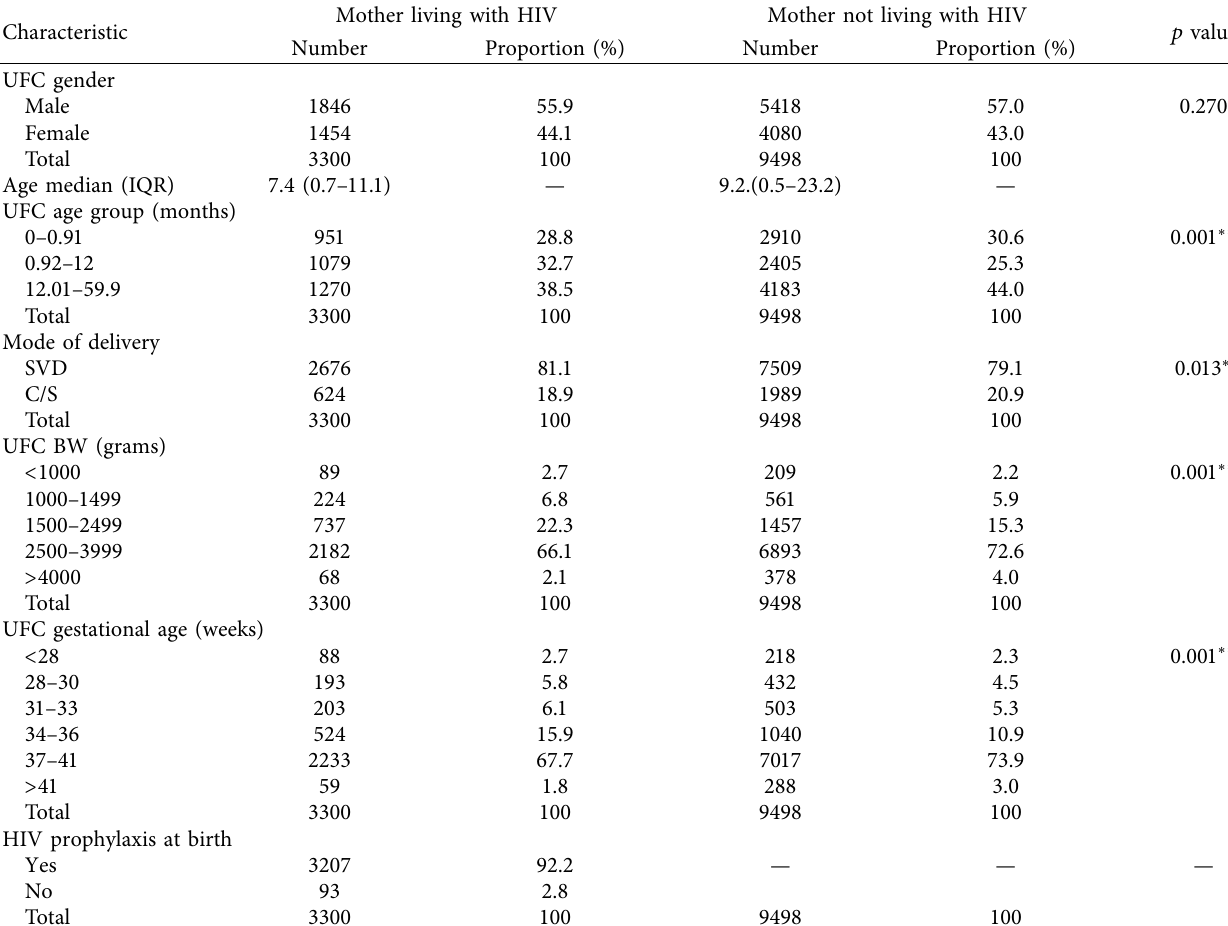
Table 1: Sociodemographic and biomedical characteristics of under-five children born to women living with and not living with HIV between January 2014 and December 2018 in Botswana ( N � 12,798). Mother living with HIV Mother not living with Characteristic